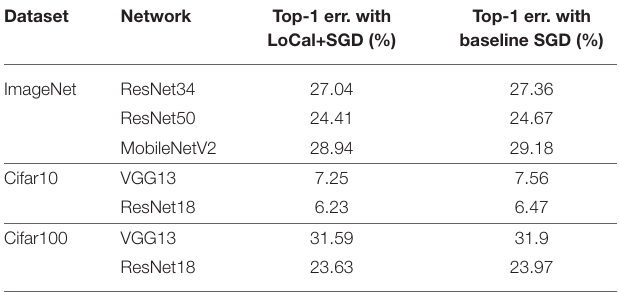
TABLE 3 | Comparing accuracy at Iso-runtime.